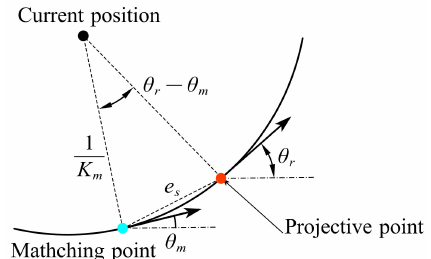
Figure 13. The heading angle of the projective